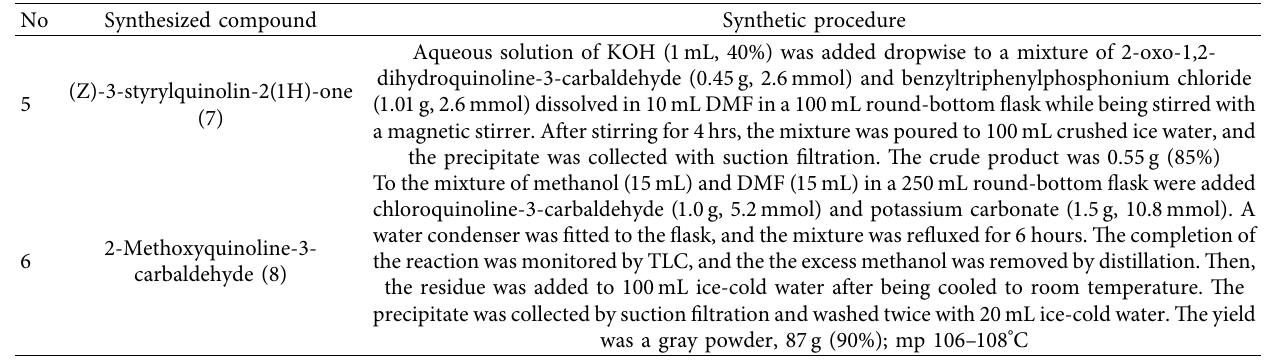
Table 2: Continued table of the synthesized compounds and their synthetic